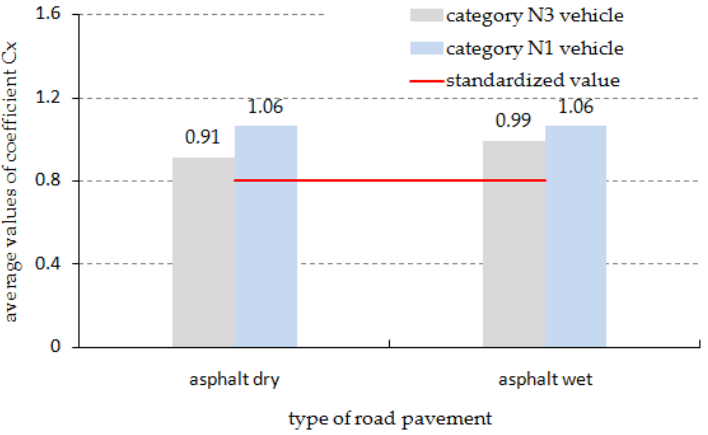
Figure 7. Average values of coefficient C x established for maximum acceleration values registered during braking tests with an initial speed of 50 km/h. Table 9. List of C (cid:2934) Cx coefficient values established for fully developed deceleration values.